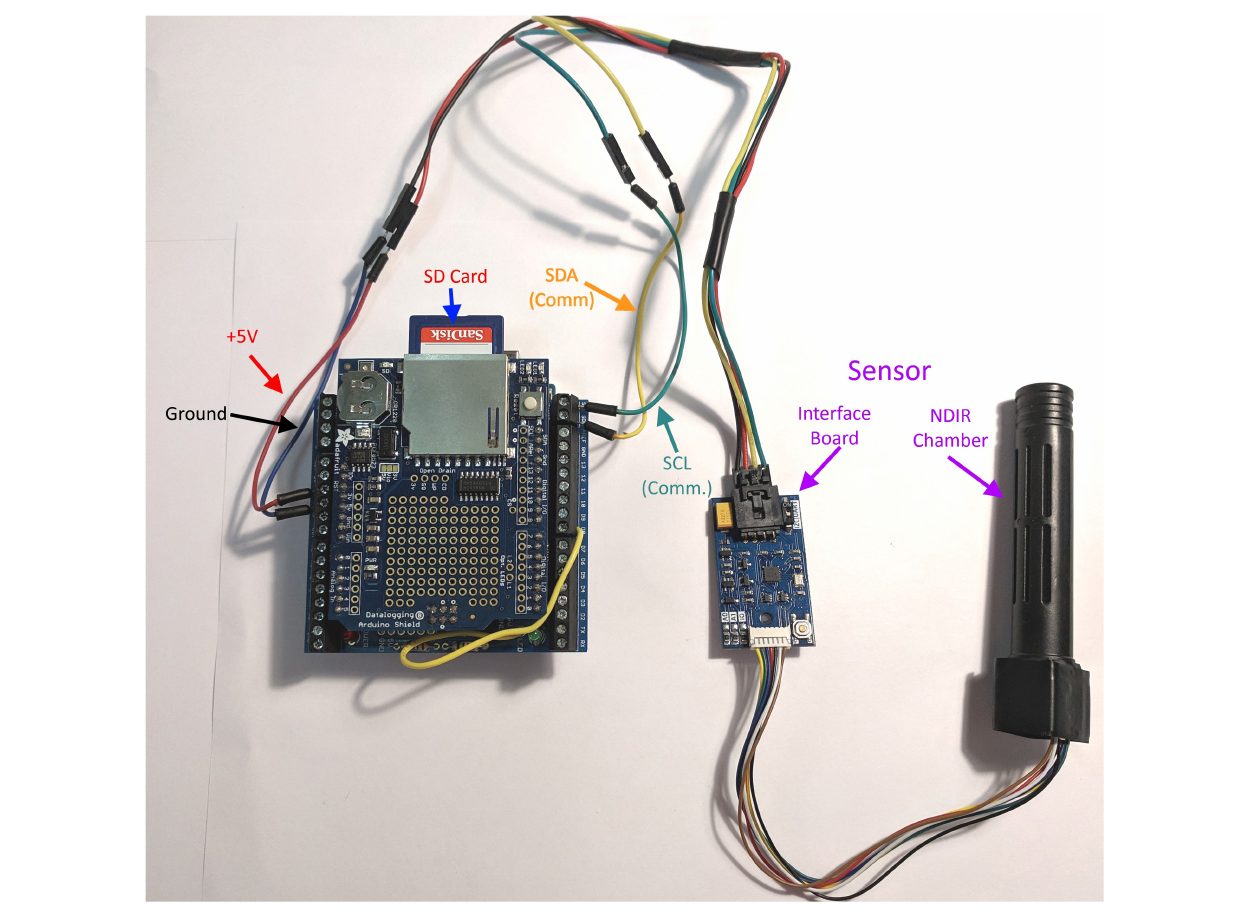
FIGURE 1 | Schematic of the soil microbial activity assessment contraption (SMAAC). NDIR, non-dispersive infrared sensor used to detect CO 2 ; SCL, serial clock line, used to synchronize data and commands between the Arduino and the interface board; SDA, serial data line, used to send and receive serial data and commands to the interface